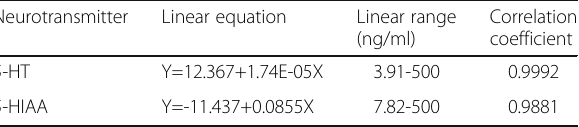
Table 1 Linear equations, linear ranges and detection limits of 5-HT and 5-HIAA Neurotransmitter